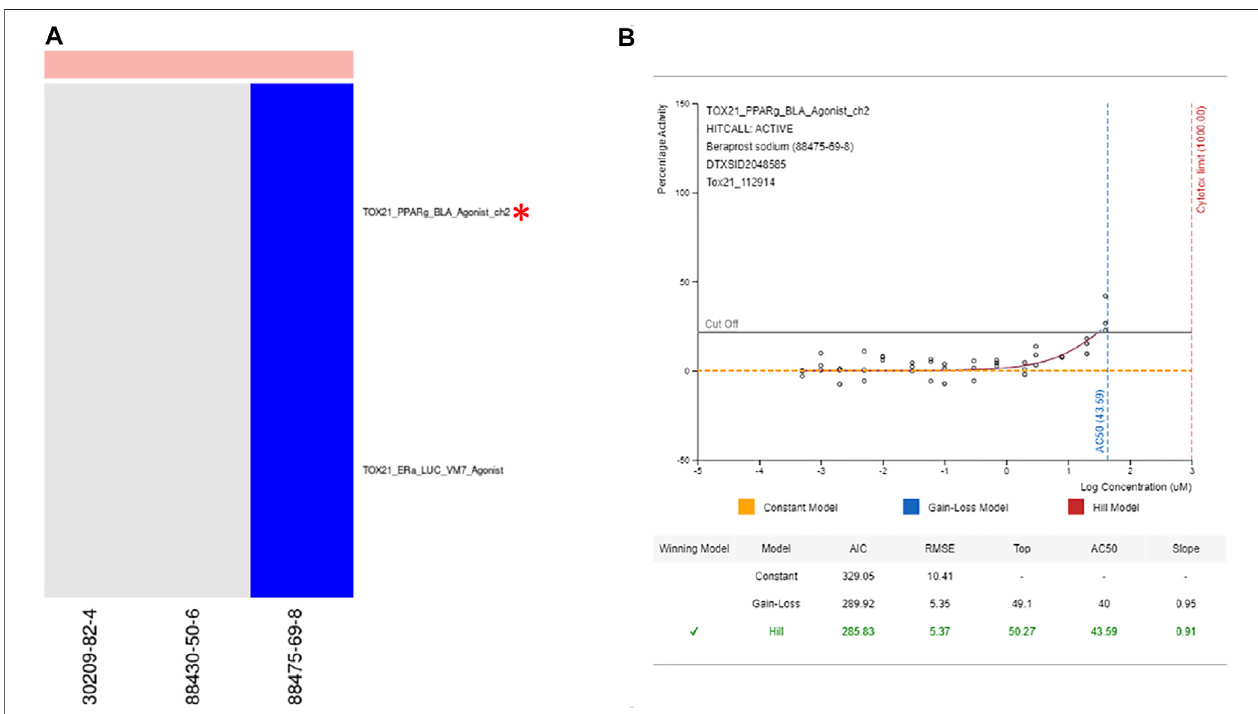
FIGURE 8 | Prostaglandin receptor agonists. (A) Heatmap showing activity for all assays where at least one chemical from cluster 941 was active. (B) Dose response curve for beraprost sodium in selected assay showing modest activity. From https://comptox.epa.gov/dashboard/dsstoxdb/results?search= DTXSID2048585#invitrodb-bioassays-toxcast-tox21. Accessed 11/19/2021. Heatmap colors: blue = active below the cytotoxicity point, light blue = active above the cytotoxicity point, white = inactive, grey = not tested. Top of heatmap: red = toxic, blue = nontoxic, aquamarine = unde fi ned. Red asterisks identify the assay(s) selected for that